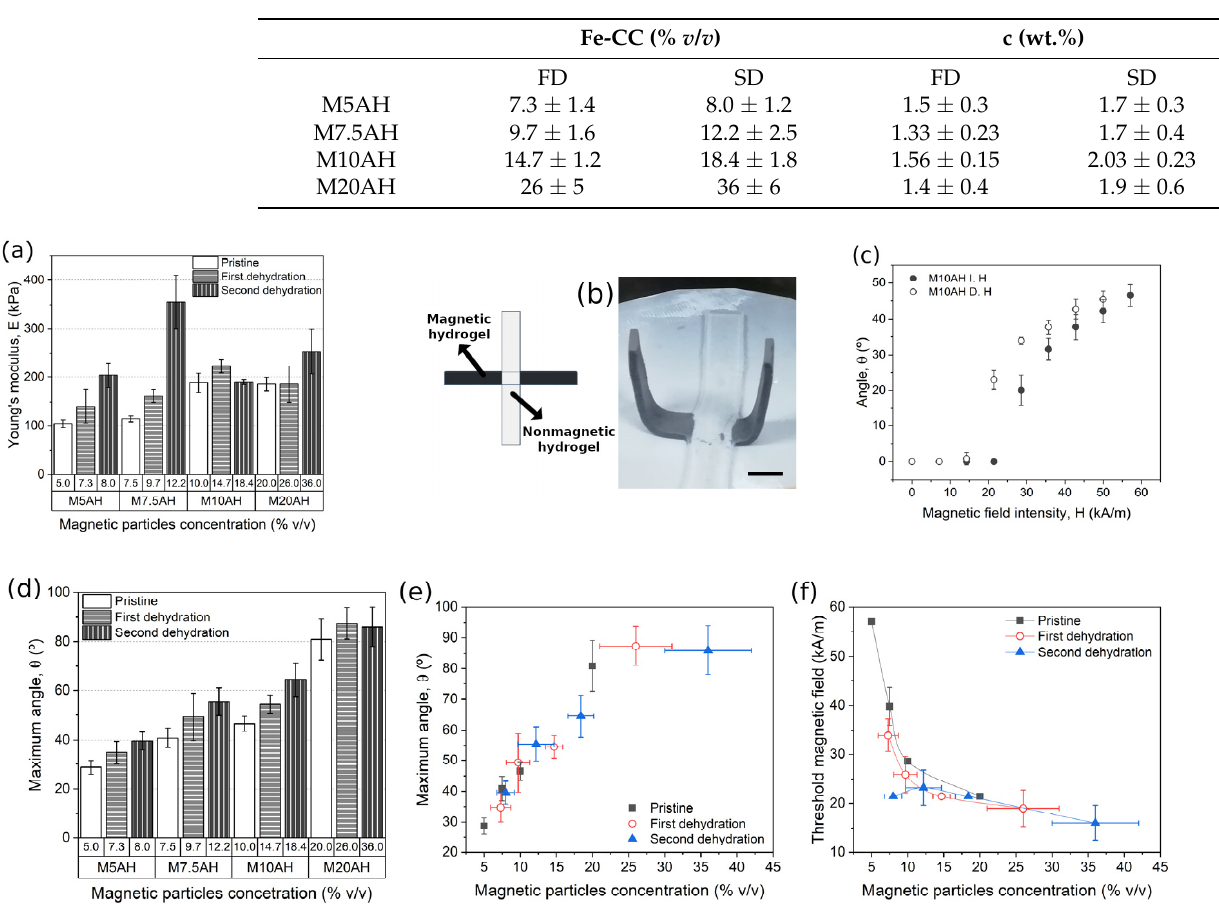
Figure 4. Mechanical response and actuation of the actuator. ( a ) Young’s modulus of the active part of the actuator before and after the two steps of dehydration under compressive stress. ( b ) Sketch and image of the actuator (on-state). Scale bar is 10 mm. ( c ) Angle as a function of the magnetic field intensity for pristine actuator with a particle concentration of 10% v / v . ( d ) Maximum angle reached by the actuator at a magnetic field intensity of 57 kA/m. ( e ) Maximum angle reached by the actuator at a field of 57 kA/m as function of the magnetic particle concentration. ( f ) Threshold magnetic field as function of the magnetic particle concentration of the